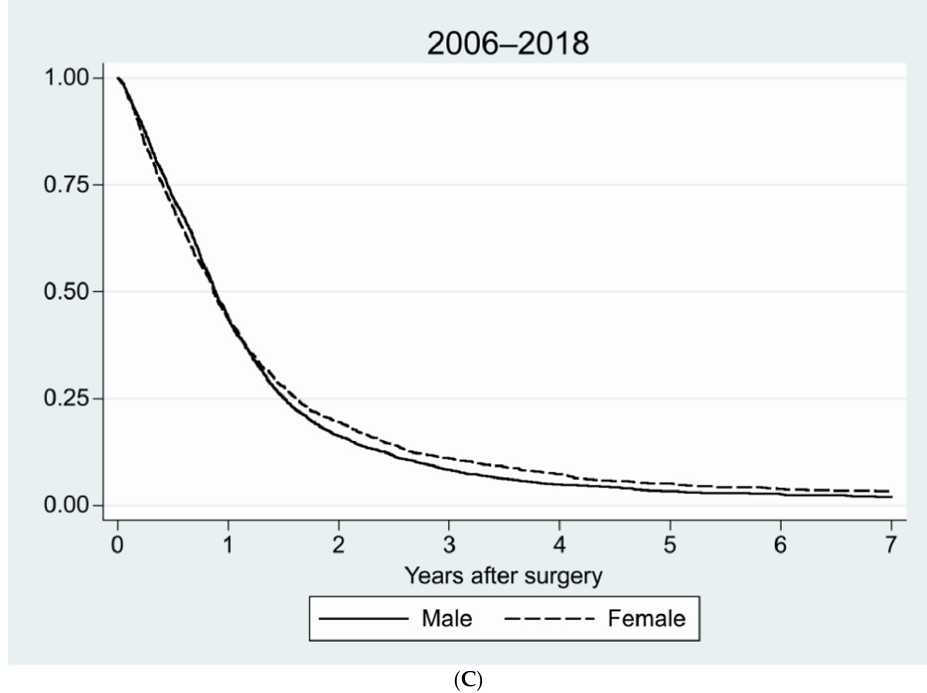
Figure 3. Survival for men and women for different time periods. ( A ) For the complete 20-year period from 1999–2018 ( p = 0.06); ( B ) 1999–2005, before temozolomide was introduced into routine treatment ( p = 0.35); ( C ) 2006–2018, after the introduction of concomitant radio-chemotherapy with temozolomide ( p = 0.10), using Kaplan–Meier survival curves. We also searched for potential differences in survival between sexes related to the type of surgery. As expected, the best survival was found for those who had undergone radical surgery and the poorest was for those biopsied only. For women with radical resection, a small but statistically significant survival advantage was noted ( p = 0.045) (Table 2 and Figure 4A–C). Table 2. Median survival in relation to sex and type of surgery. Better survival was noted for more extensive surgery, with a sex difference for radical resection favoring women. Significant p-value in bold.